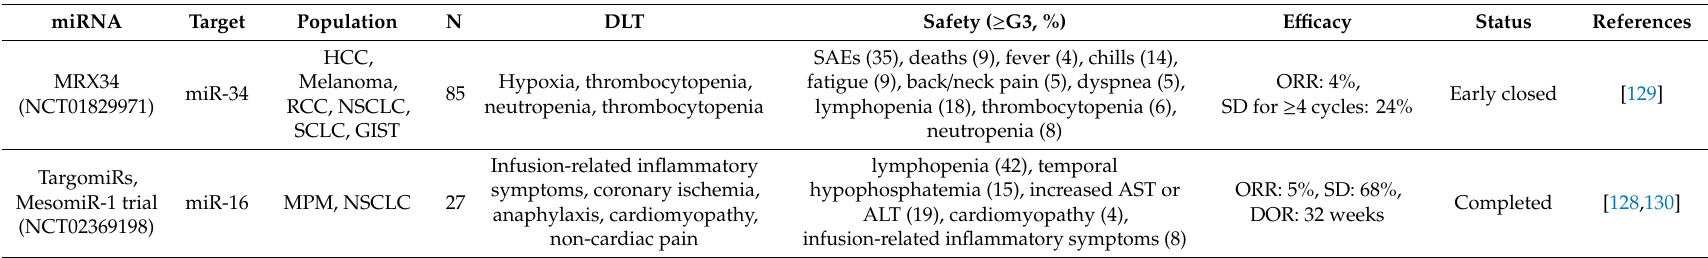
Table 2. miRNA-based Therapy Phase I Clinical Trials in